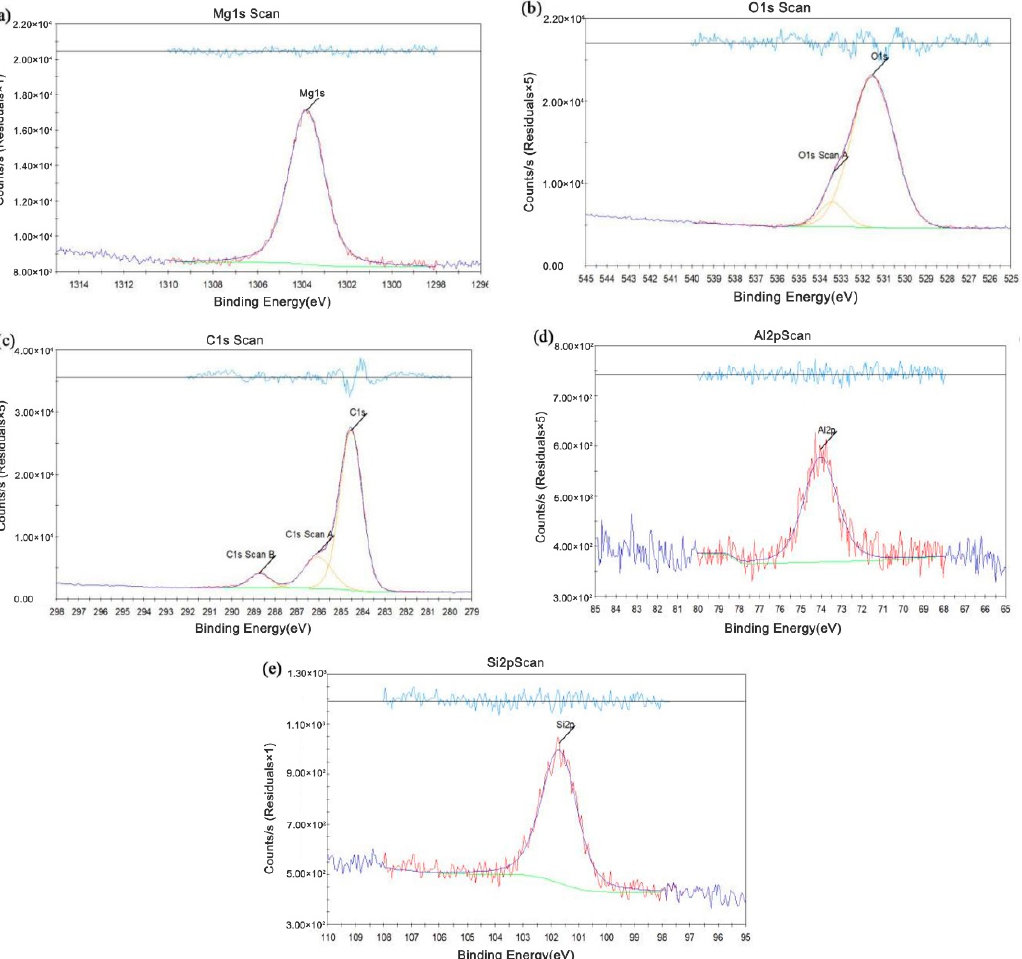
Figure 10. EPMA of the B region in Figure 5d. Elements distribution of ( a ) Al, ( b ) Si, ( c ) Mg, and ( d ) C.